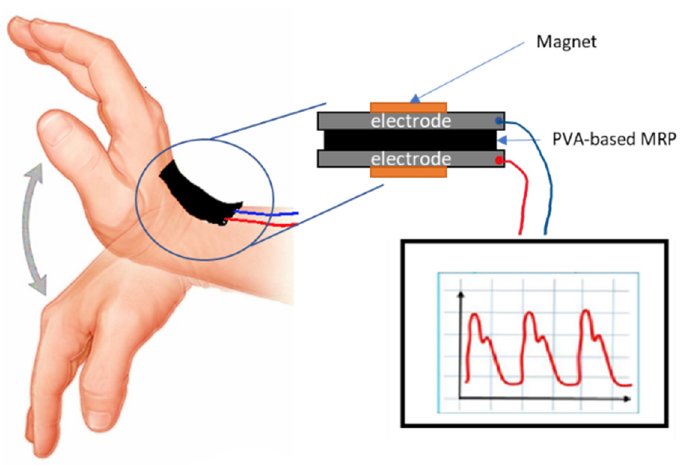
Figure 1. Basic structure of the proposed PVA-based MRP as a pressure/strain sensor to detect human motion (bending and stretching).